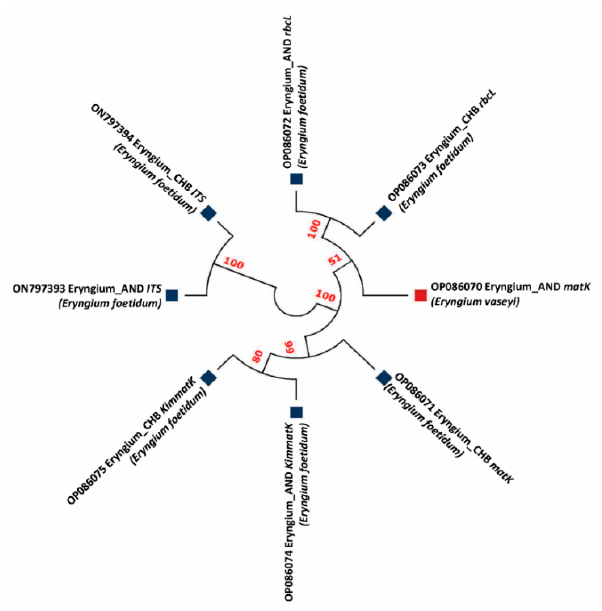
Figure 3. Maximum likelihood tree of matK , Kim matK , rbcL , and ITS2 barcode primers depicting the phylogenetic relationship among two Eryngium genotypes. The bootstrap scores (1000 replicates) are shown ( ≥ 50%) for each branch.